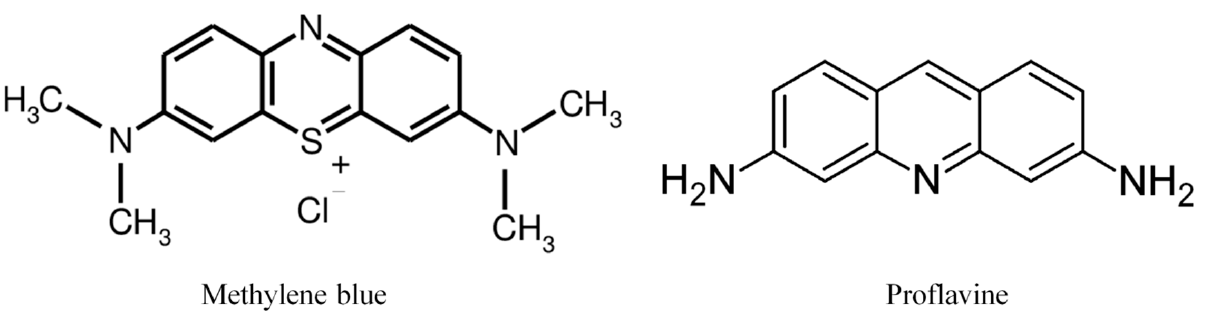
Figure 1. The chemical structure of methylene blue ( left ) and proflavine ( right ). Leung et al. [25] introduced the concept of functional perforasome based on more anatomic perforasome units. Its assessment can be done only in vivo, and the choke vessels which bind the anatomic perforasomes strongly influence the surface of functional perforasome and the number of irrigated anatomical units,